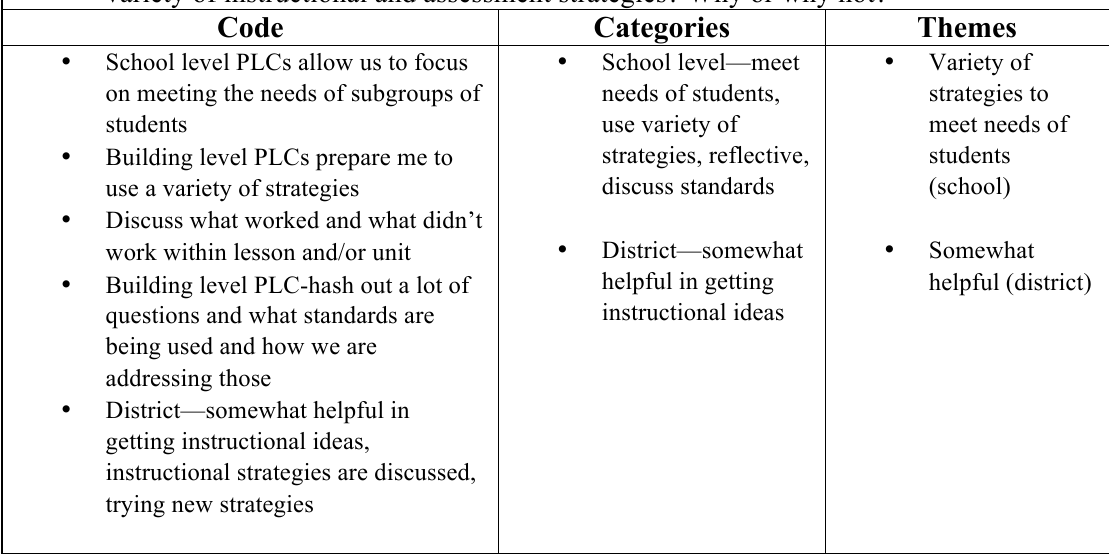
Teacher Question Thirteen and Codes 13. Do the PLC meetings and district vertical meetings prepare you to use a variety of instructional and assessment strategies? Why or why